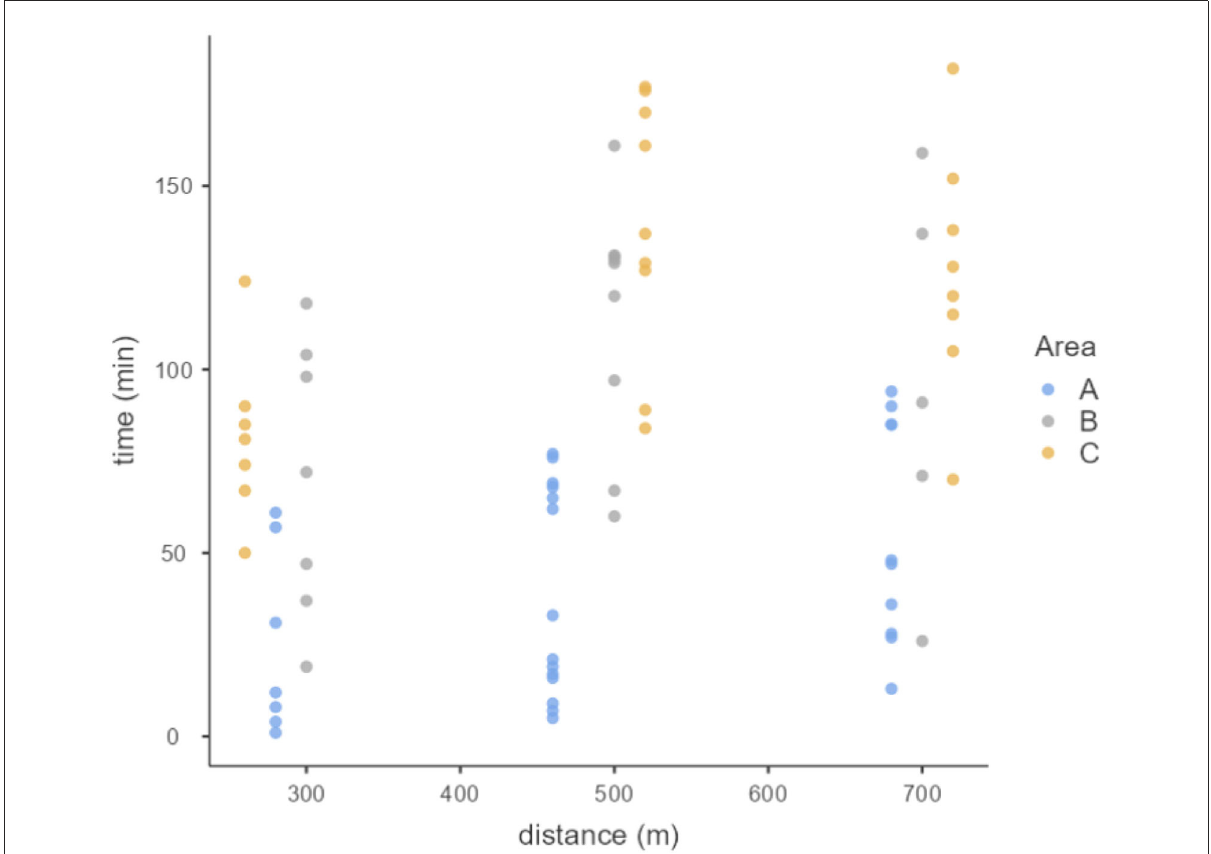
FIGURE2 Dispersion graph showing the return time (minutes) of each bee according to the release point distance for each study area (A, B, C).